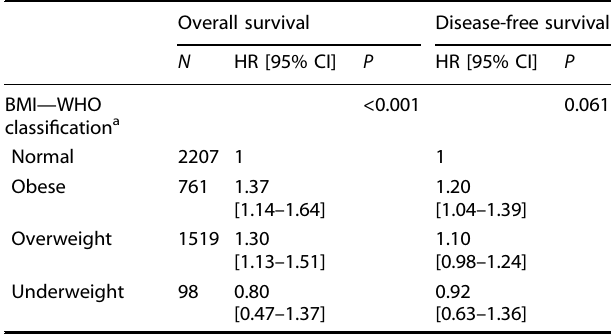
Table 1. Adjusted analysis of pretreatment body mass index with survival outcomes in EBC.